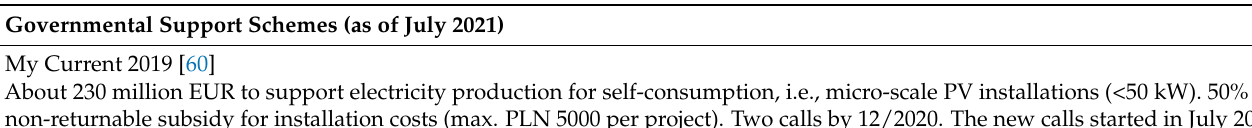
Table 3. Overview of current support schemes for individual or collective prosumer